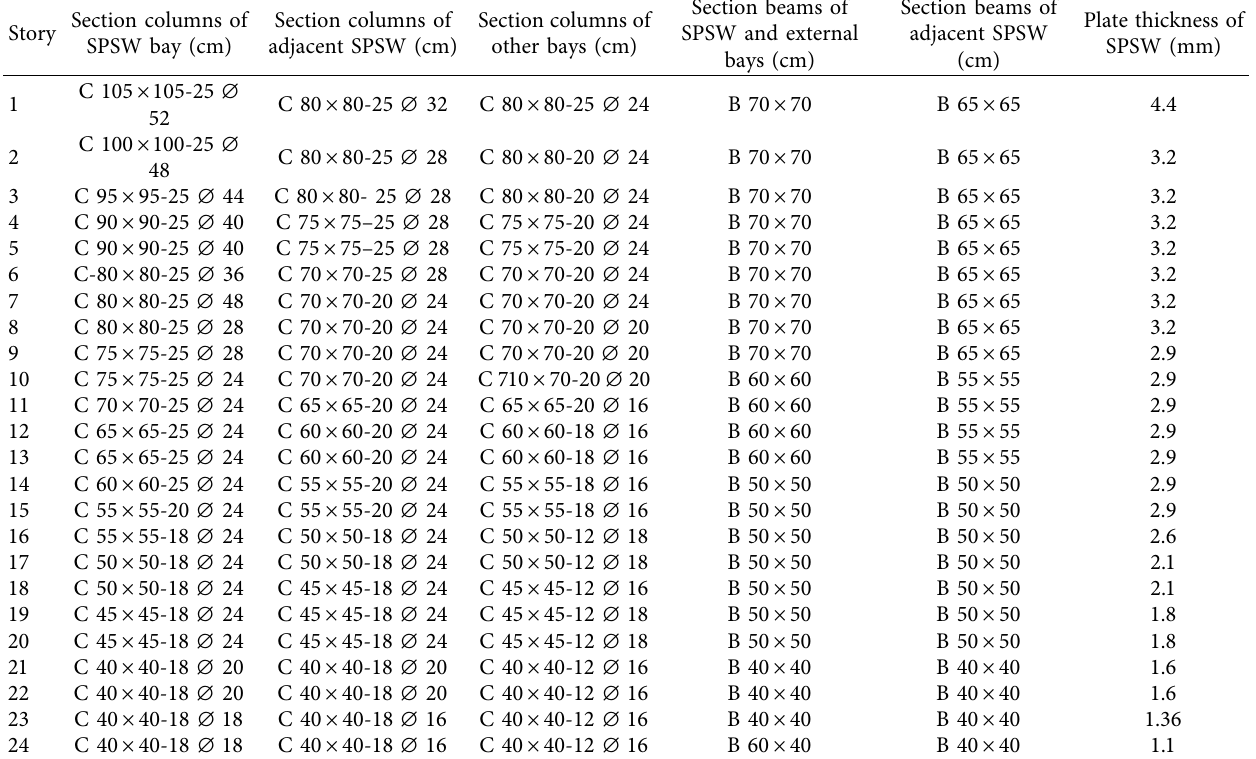
Table 5: Properties of designed beams, columns, and steel plate shear walls of 24-story model.